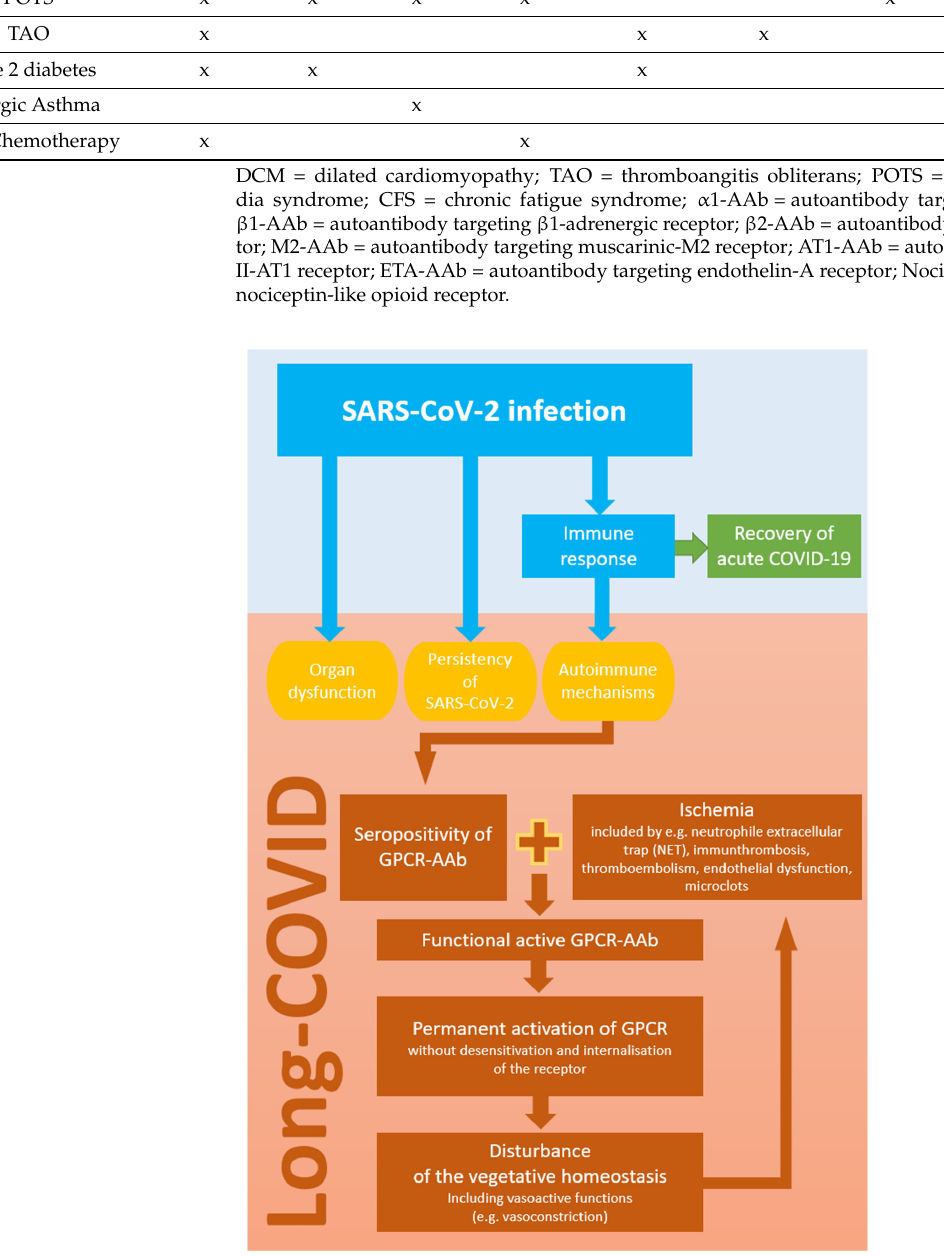
Figure 5. Schematic hypothesis of GPCR-AAb-mediated autoimmunity in Long COVID: a seroposi- tivity of GCPR-AAb and ischemia might induce a vicious circulus.